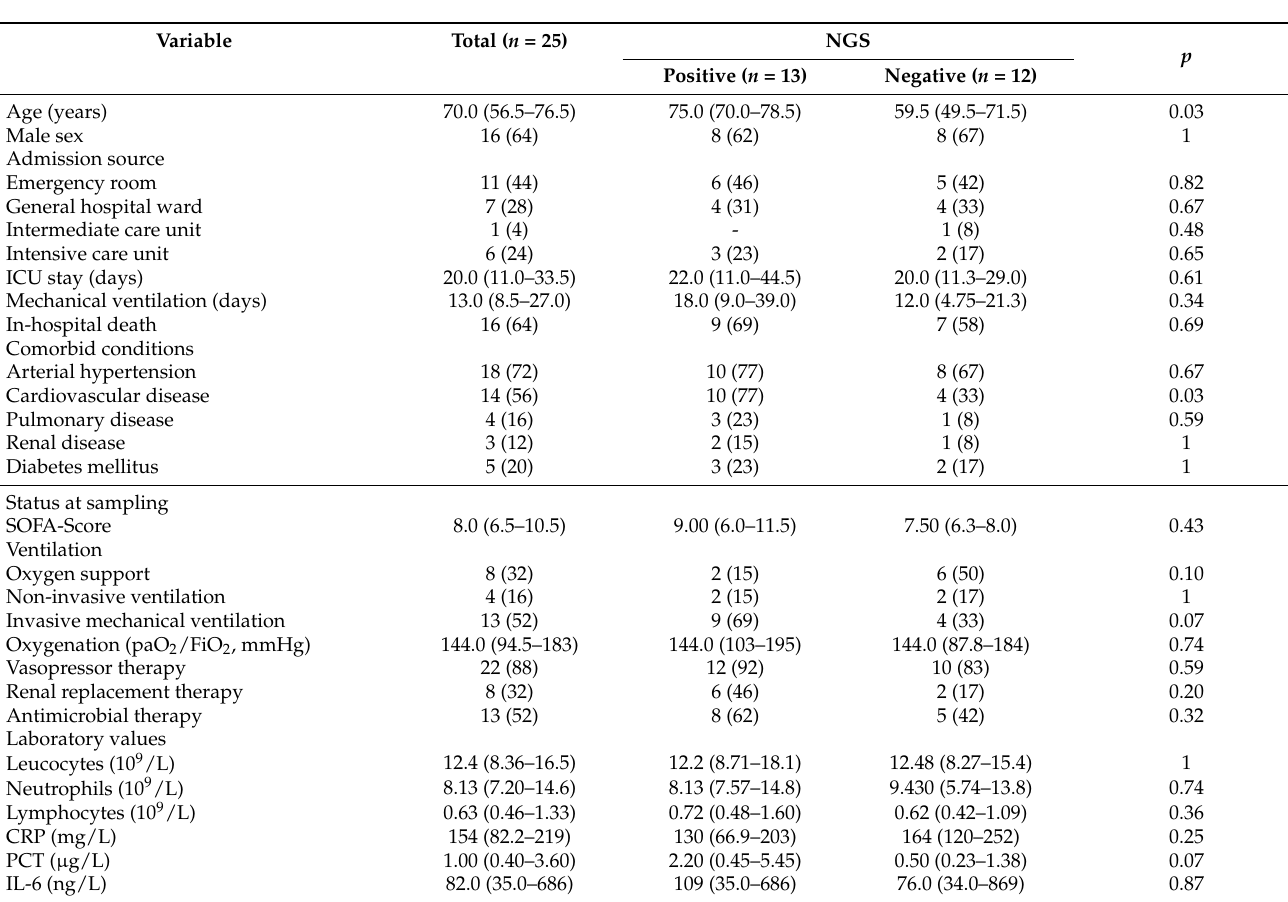
Table 1. Demographic data and clinical variables at the time of sampling. Demographic and clinical data showed no relevant differences regarding NGS positivity. Data are presented as the median and interquartile range or as counts and percentages, as appropriate. CRP: C-reactive protein; ICU: intensive care unit; IL-6: interleukin 6; NGS: next-generation sequencing; PCT: Procalcitonin; SOFA: sequential organ failure